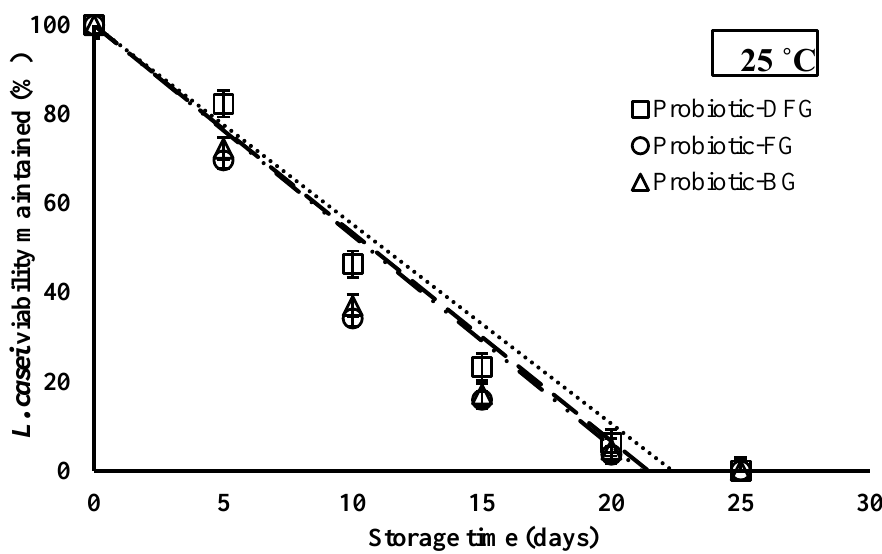
Figure 1. Inactivation curves of L. casei during storage at room temperature (25 °C) in different gelatin matrices for 25 days. DFG: Duck feet gelatin, FG: Fish gelatin, BG: Bovine gelatin